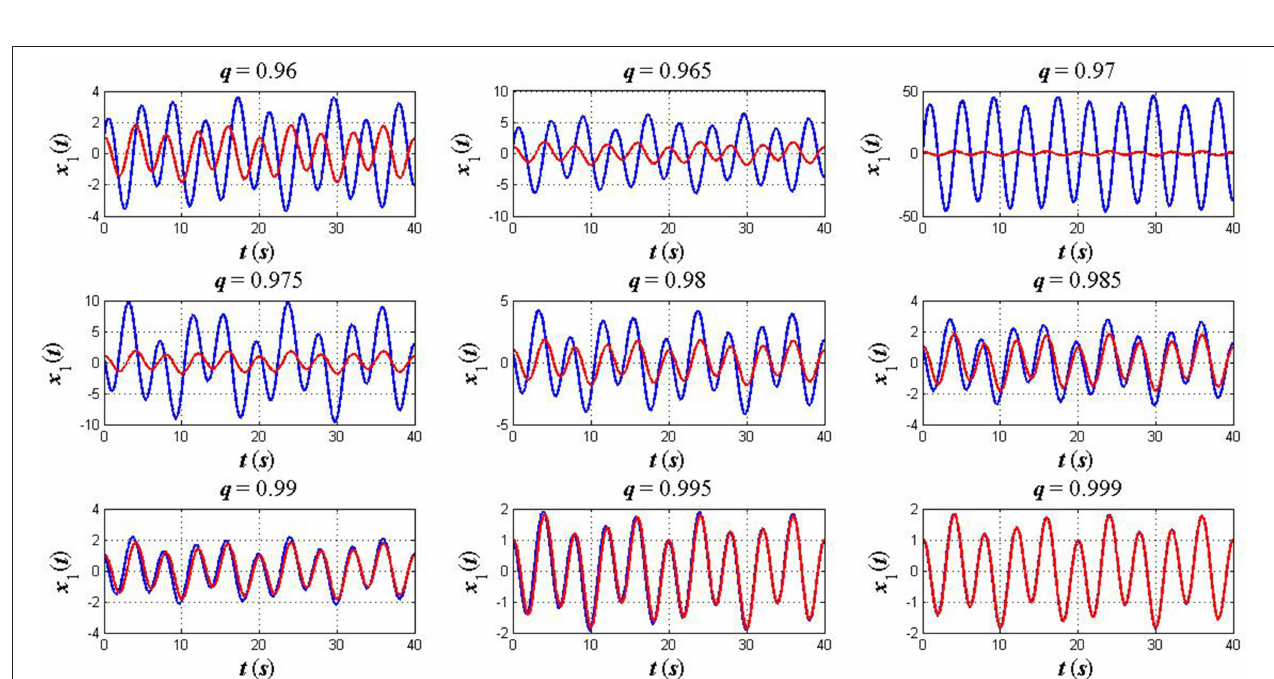
FIGURE 2 | The plots of x 1 ( t ) in the fractional sense (blue) and classical sense (red): a symmetric initial position x 1 (0) = − x 2 (0) = 1.